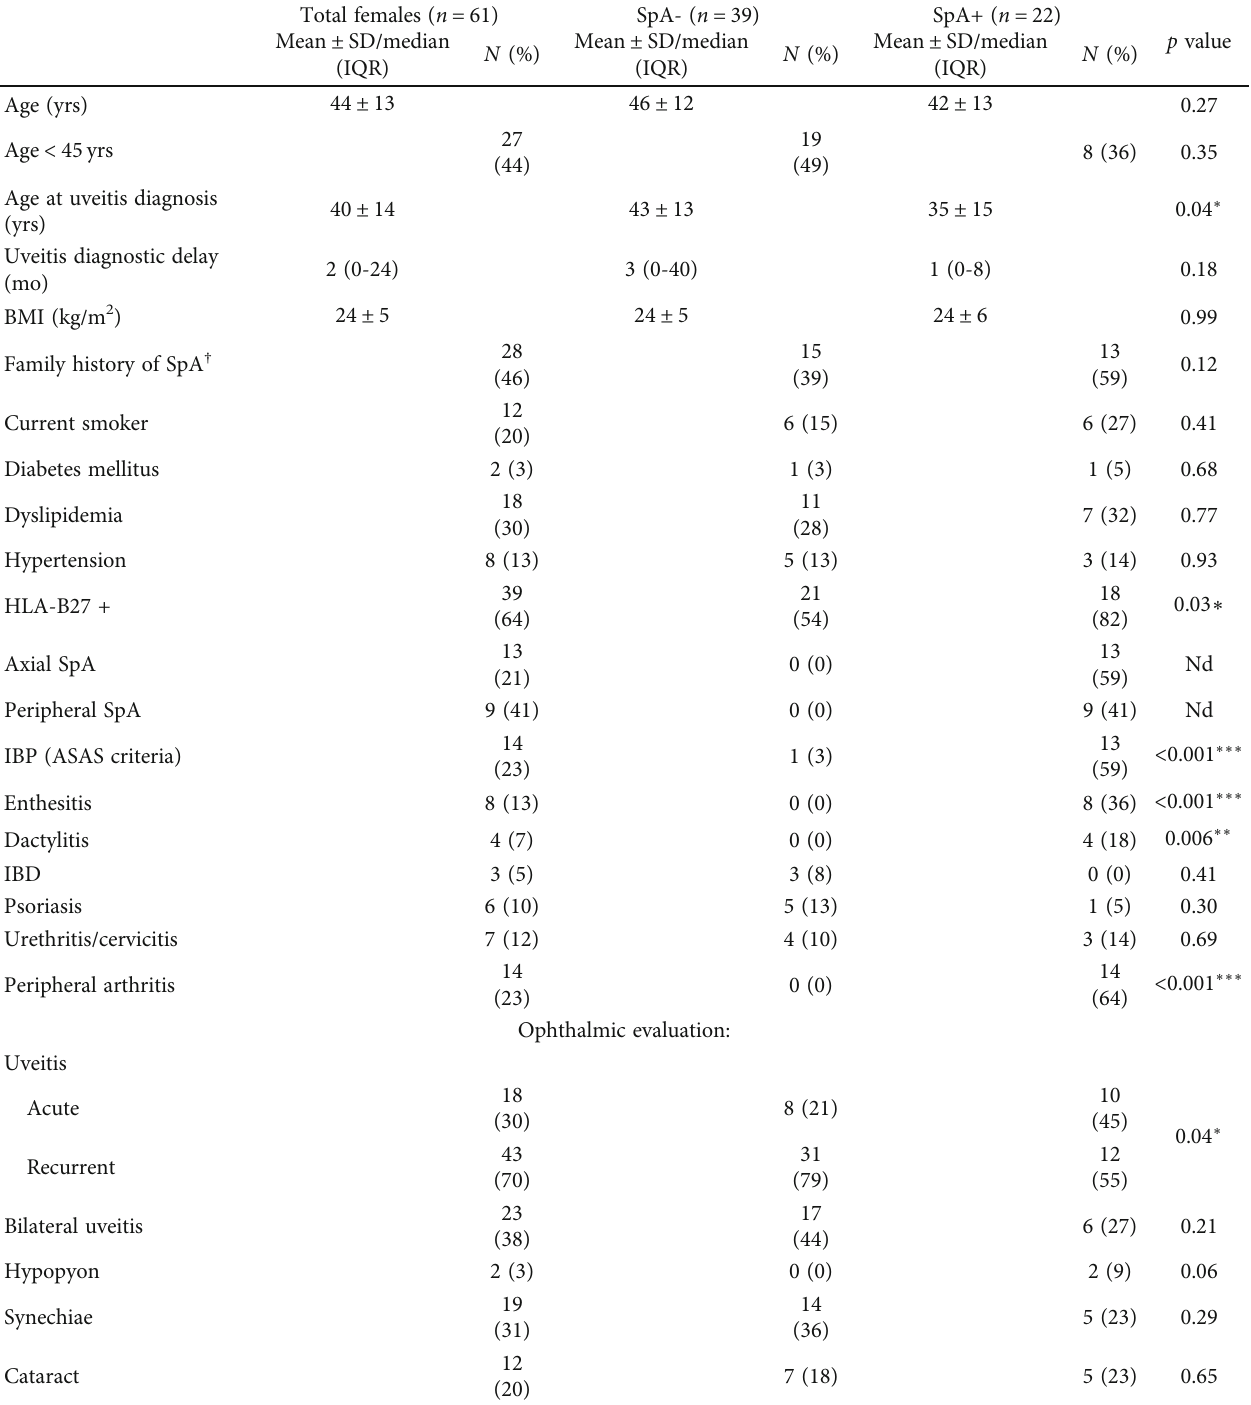
Table 3: Main characteristics of study population according to female